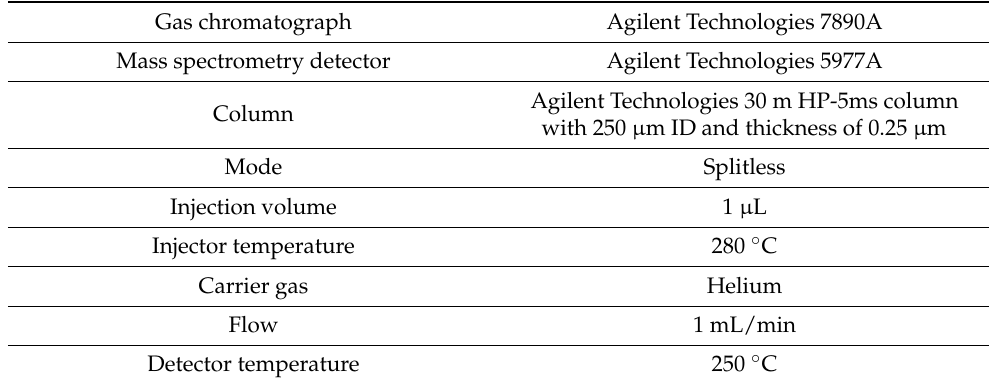
Table 4. Specification of GC-MS instrument and instrumental conditions.